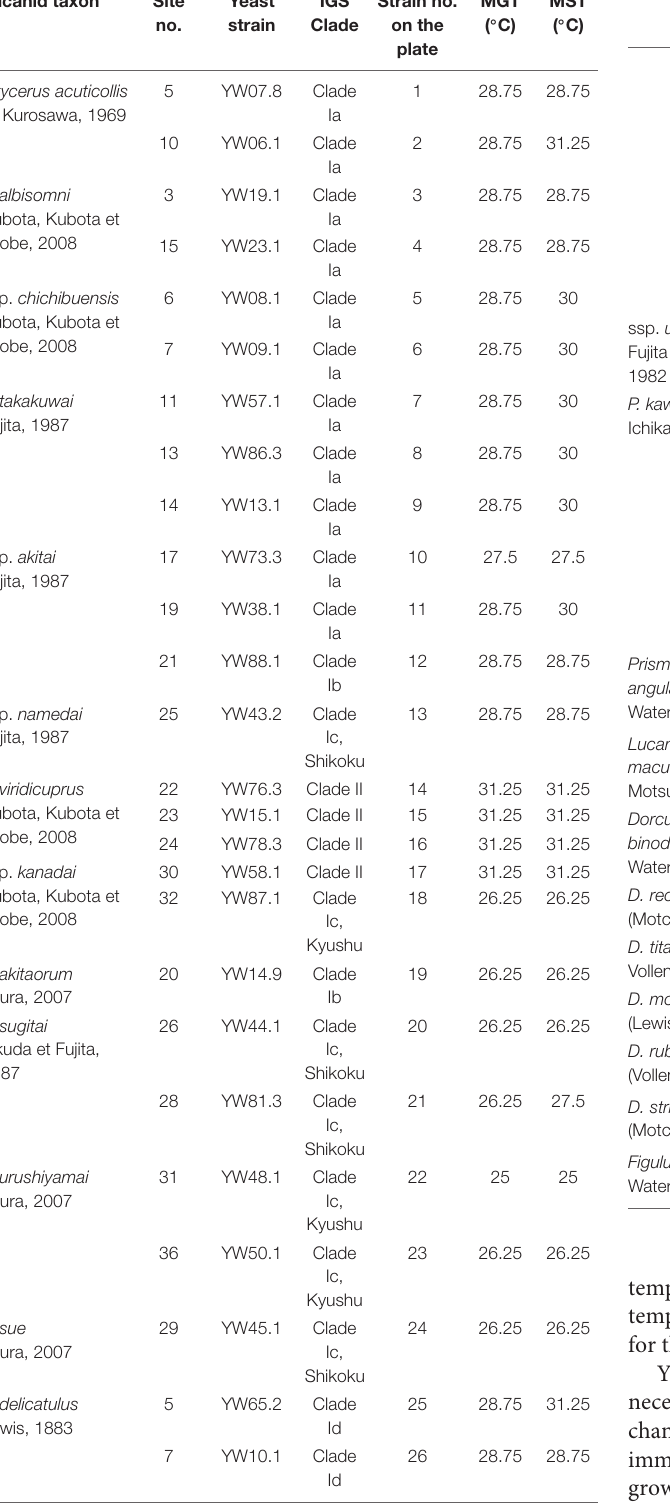
TABLE 1 | Samples used to determine the maximum growth temperature (MGT) and maximum survival temperature (MST). Lucanid taxon Site